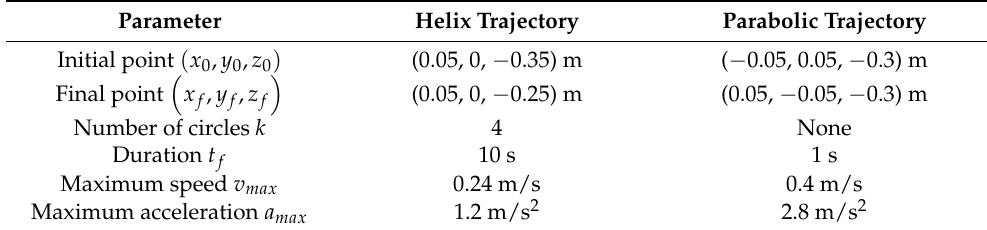
Table 4. The parameters of helix and parabolic trajectory for Delta robot. Parameter Helix Trajectory Parabolic Trajectory Initial point ( x 0 , y 0 , z 0 )